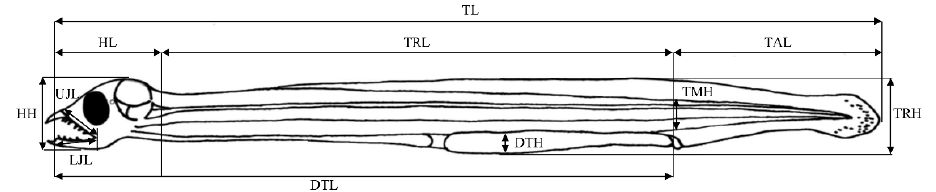
Figure 2. Morphometric measurements in Anguilla japonica larvae. Abbreviations: DTH, digestive tract height; DTL, digestive tract length; HH, head height; HL, head length; LJL, lower jaw length.; TAL, tail length; TL, total length; TMH, tail muscle height; TRH, trunk height; TRL, trunk length; UJL, upper jaw length.